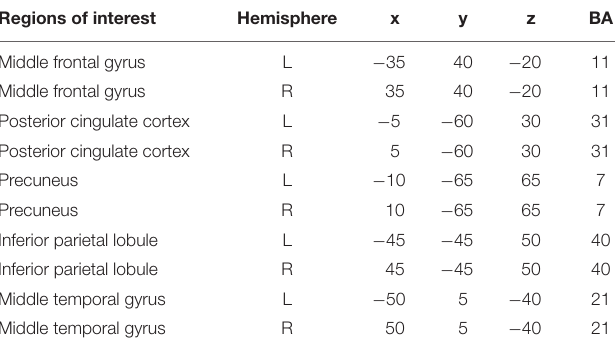
TABLE 1 | The Coordinates of ROIs in the